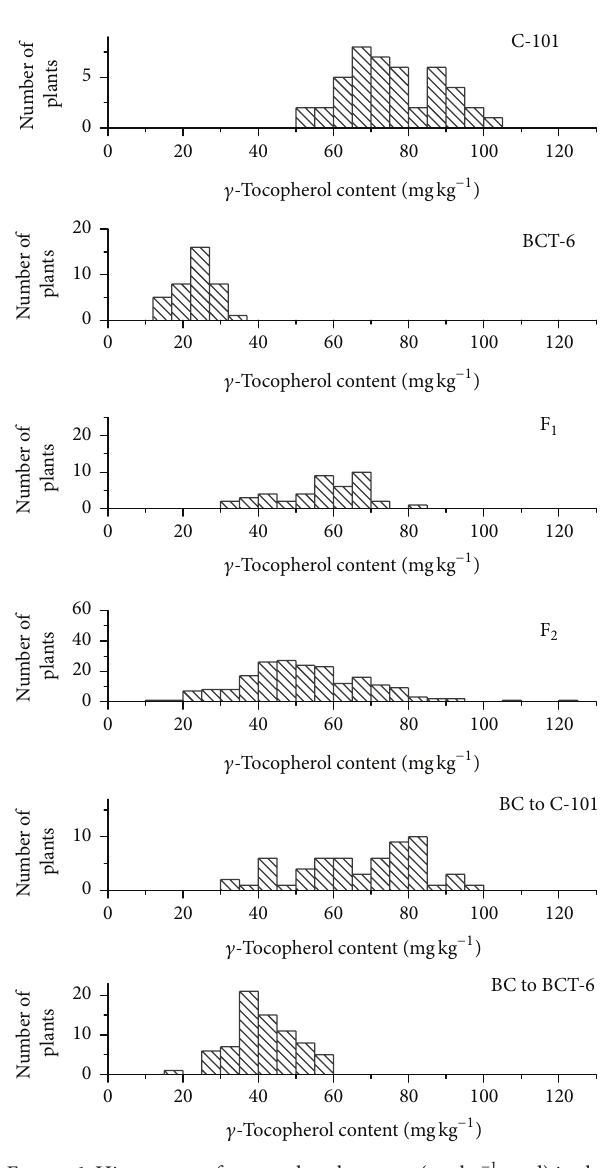
Figure 1: Histograms of 𝛾 -tocopherol content (mgkg −1 seed) in the Ethiopian mustard lines C-101 and BCT-6 and the F 1 , F 2 , and BC generations derived from their